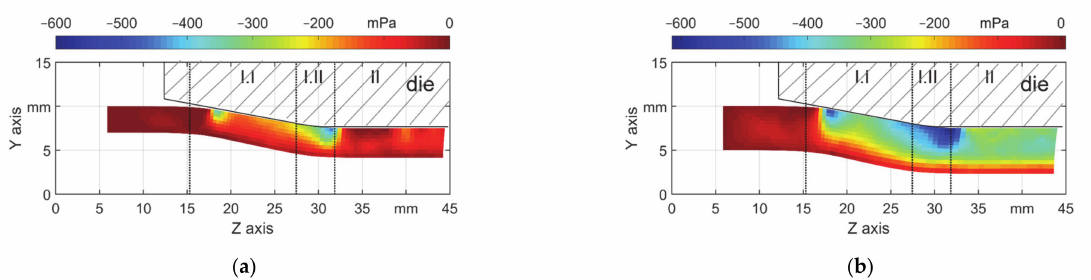
Figure 13. Radial stress field (S 11 ) for µ = 0.18, ( a ) s 0 = 3 mm and ( b ) s 0 = 5